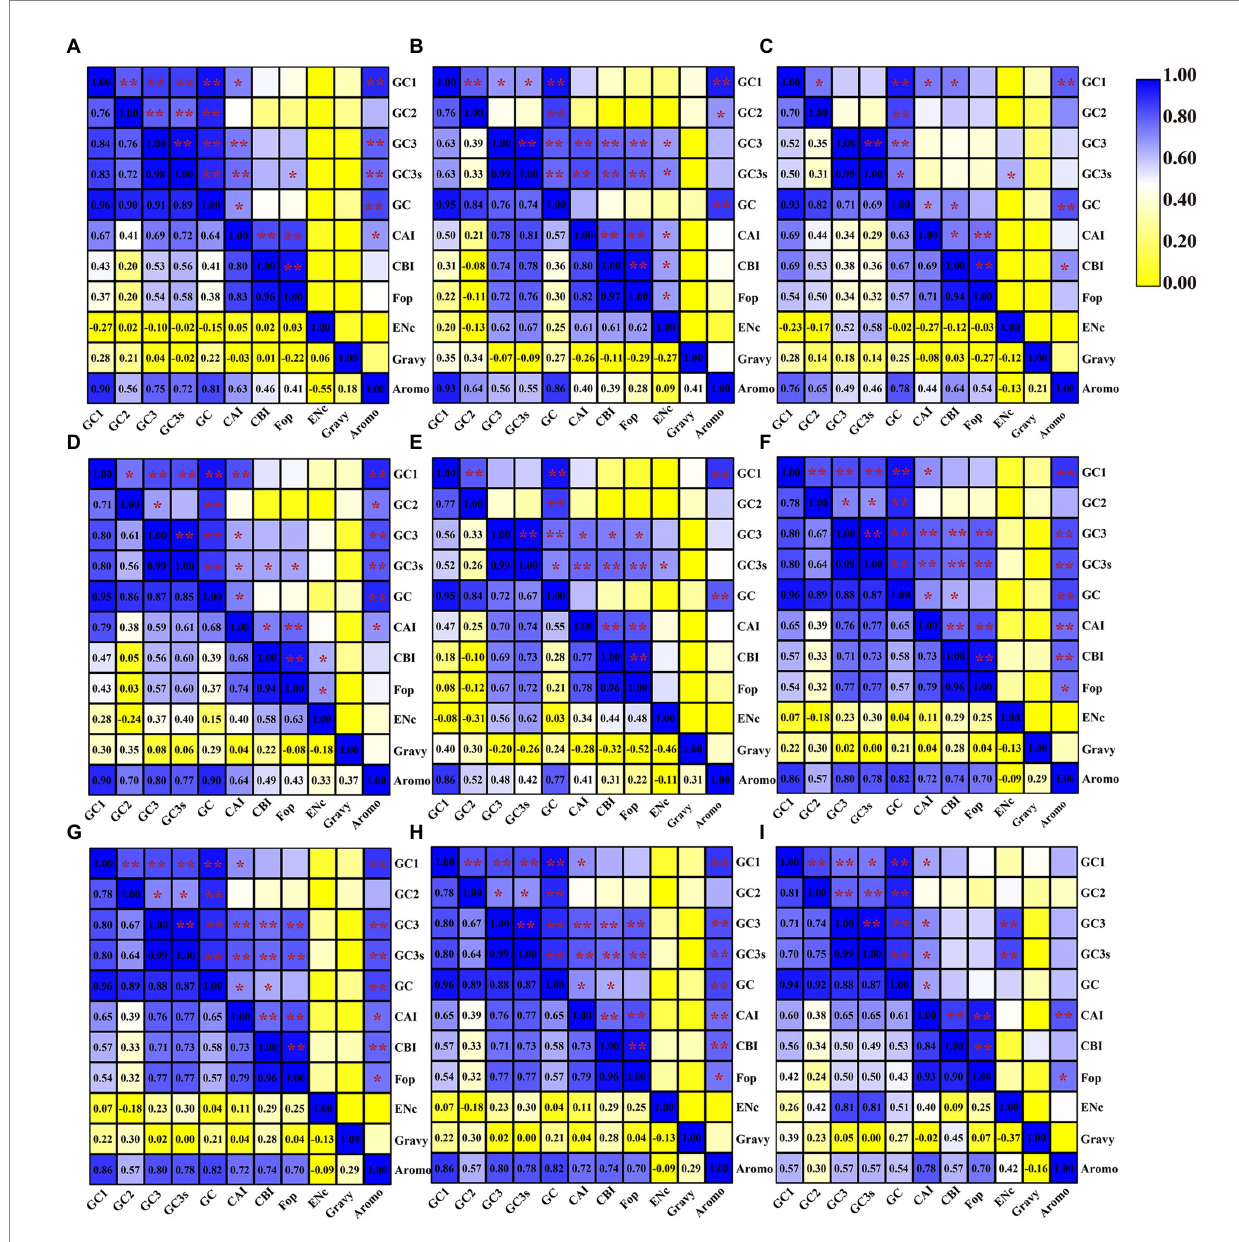
FIGURE 2 Pearson’s correlation analysis heatmap of different codon usage indicators of nine Amanita species. The color of the color block changes from yellow to blue, indicating that the correlation index is increasing. One asterisk indicates a significant correlation between the two indicators at the p < 0.05 level, while two asterisks indicate a significant correlation between the two indicators at the p < 0.01 level. (A) , A. basii ; (B) , A. bisporigera ; (C) , A. brunnescens ; (D) , A. muscaria ; (E) , A. phalloides ; (F) , A. pseudoporphyria ; (G) , A. sinensis ; (H) , A. inopinata ; and (I) , A. thiersii